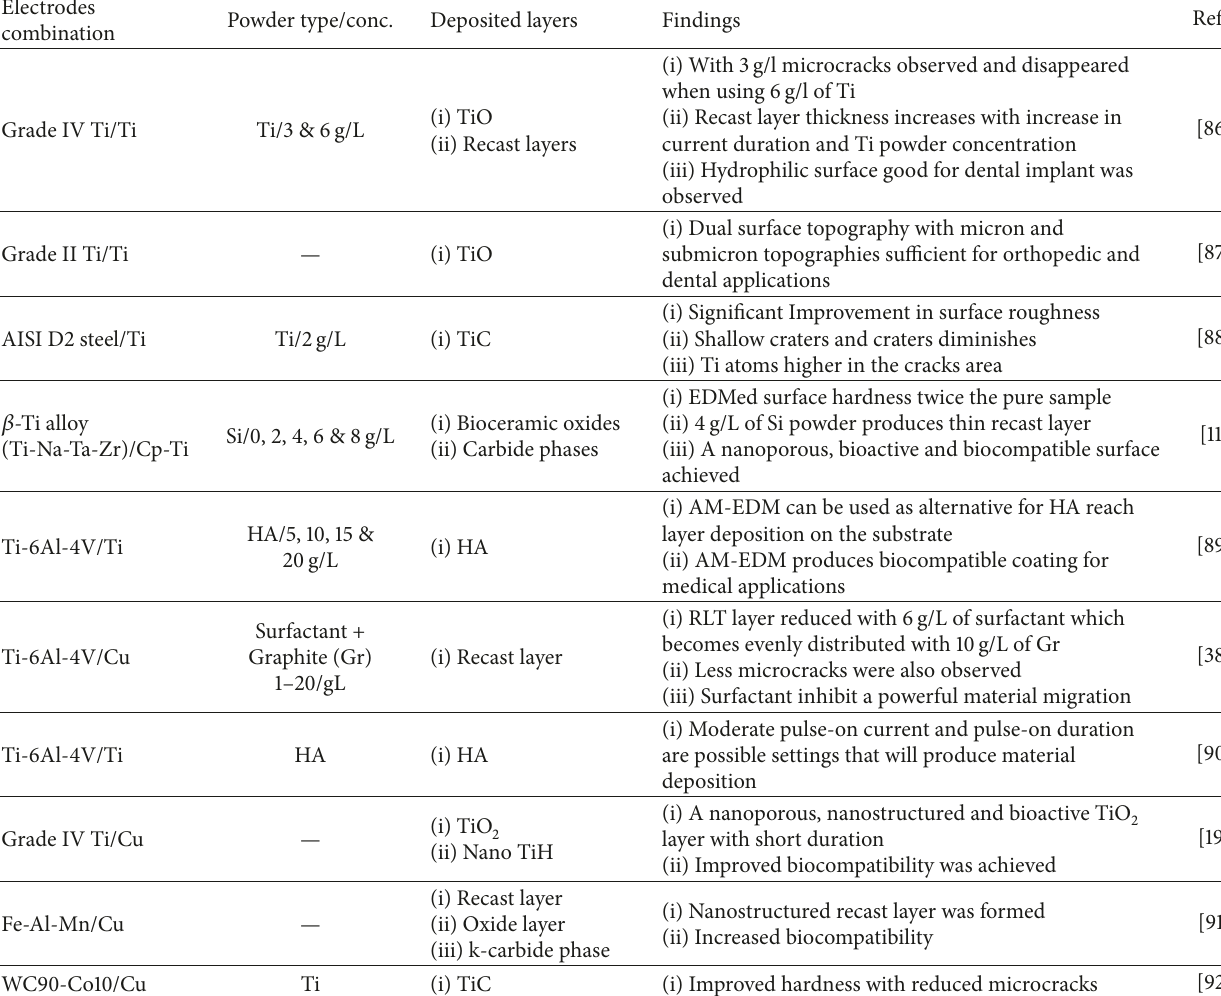
Table 6: Critical review of recent development of material deposition and surface treatment of metallic implant through AM-EDM.